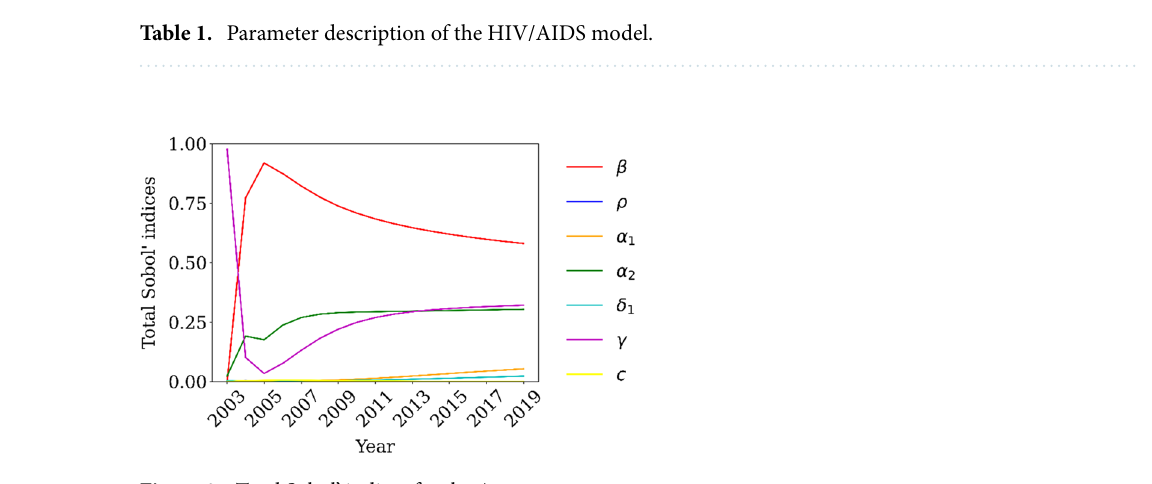
Figure 3. Total Sobol’ indices for the A compartment.